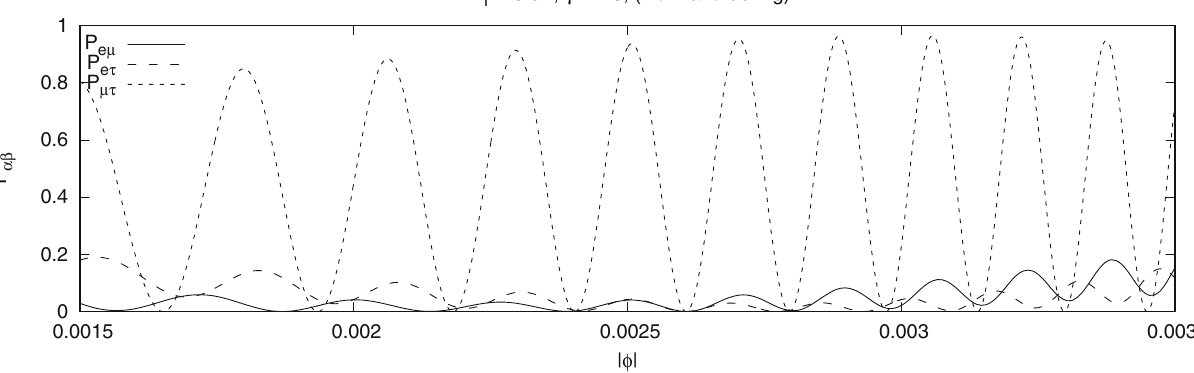
tively.Wetake r D = 10 8 km, r S = 10 5 r D , M ADM = 1 M (cid:15) and E 0 = 10 MeV. Neutrino mass squared differences, mixing angles and the Dirac CP phase are taken from the latest global fit